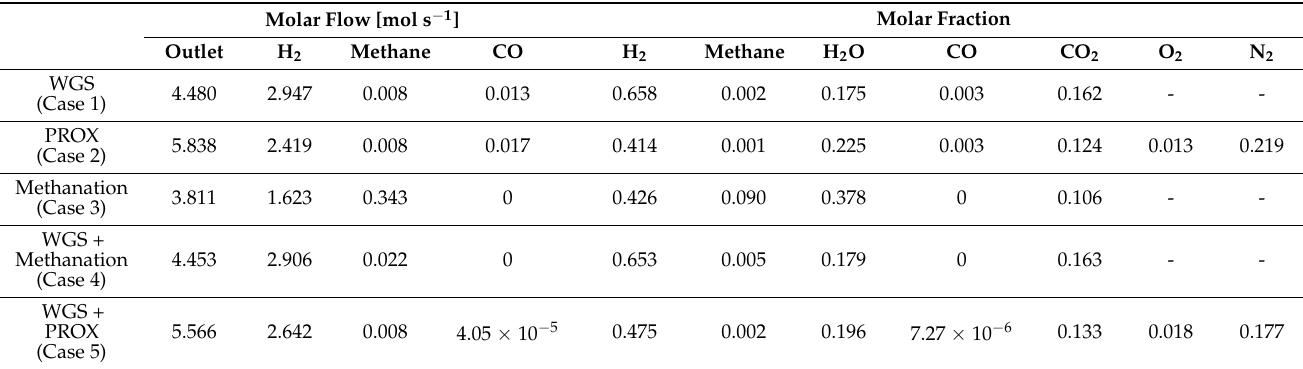
Table 8. Overall